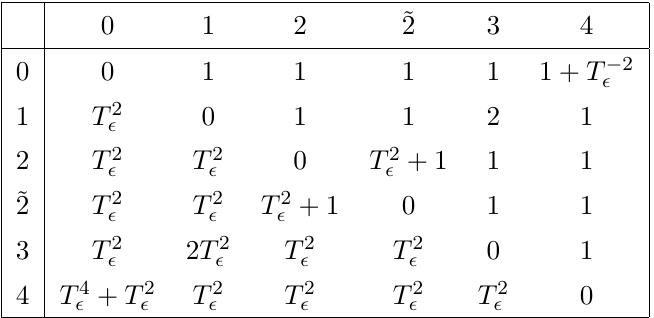
This table gives X (cid:0) T